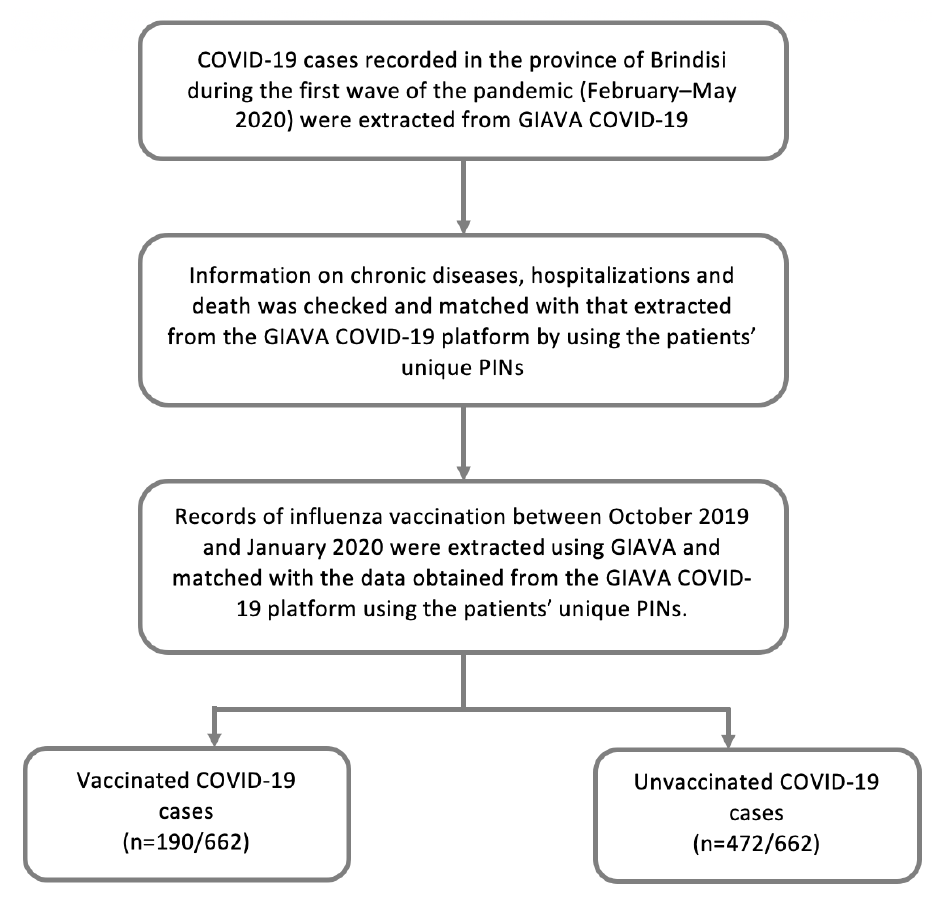
Figure 1. Study population.